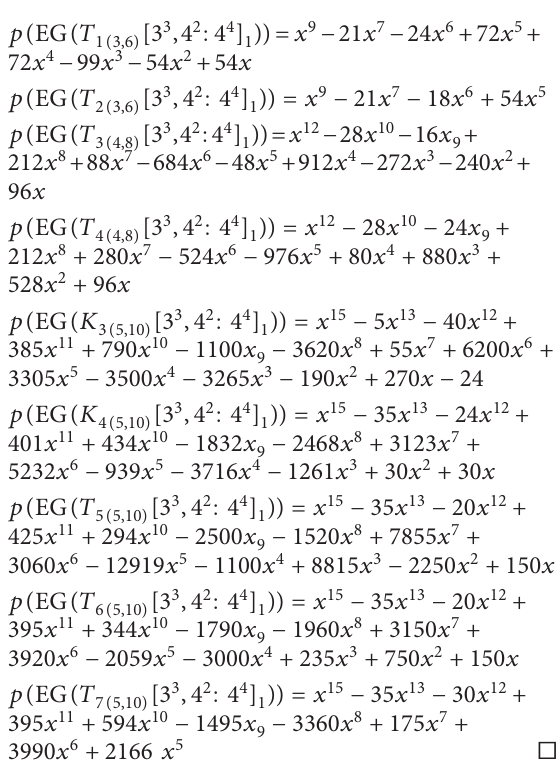
Figure 7: Doubly semiequivelar map 3 , 4 2 : 1(4,8) [3 T [ 3 3 , 4 2 : 4 4 ] 7 ( 5 , 10 ) [ 3 3 , 4 2 : 4 4 ] (d) K 3 ( 5 , 10 )